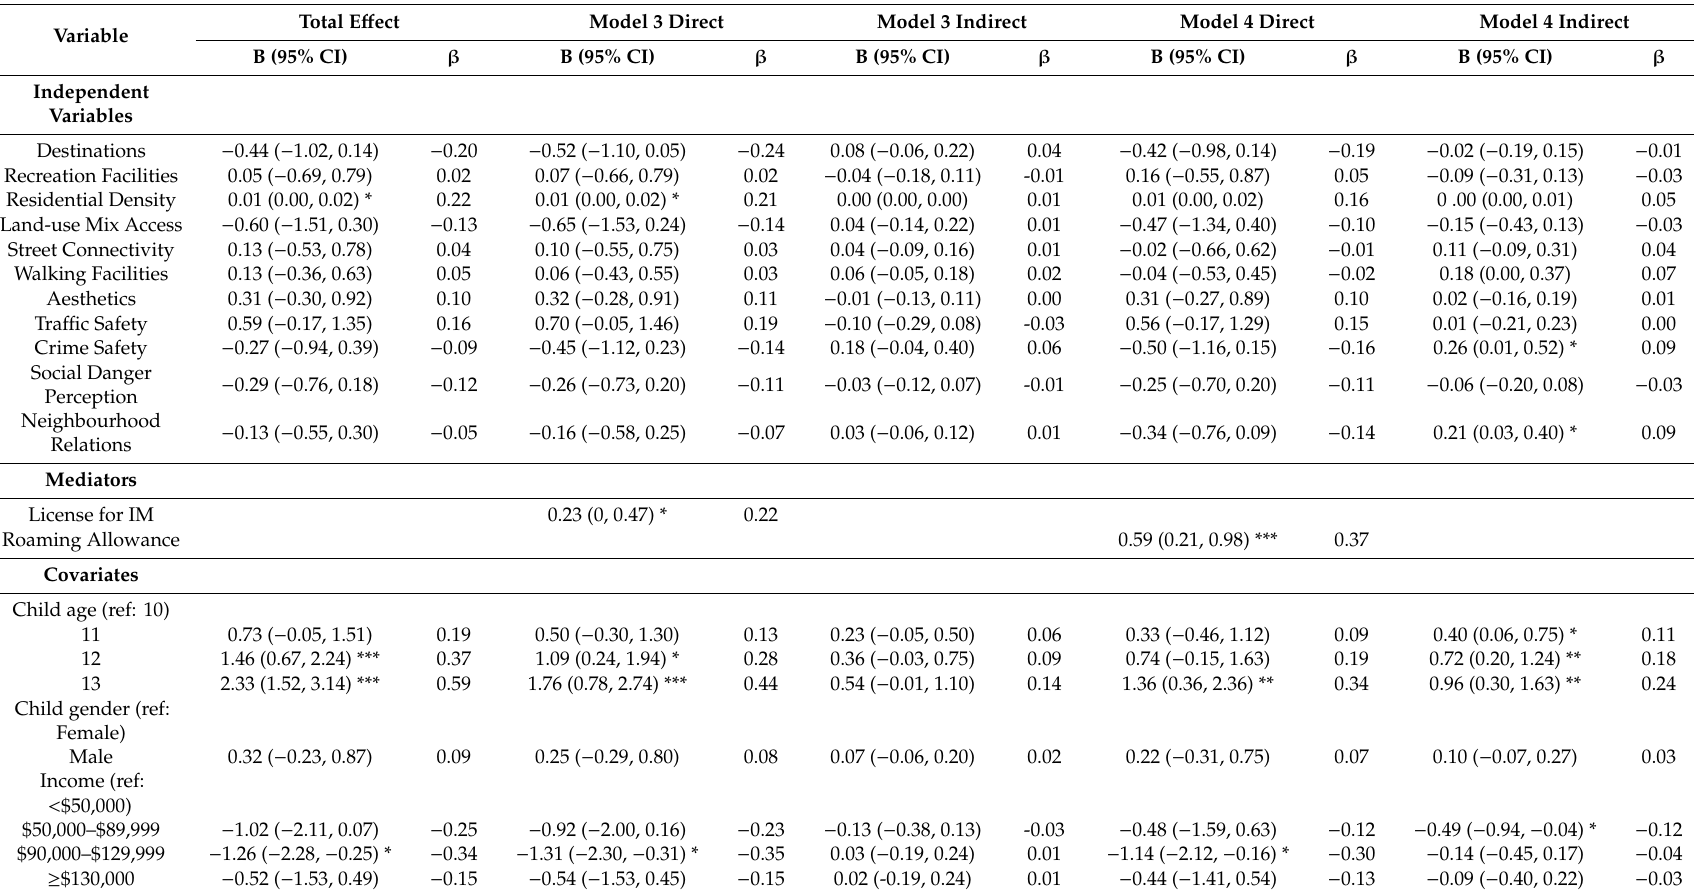
Table 5. Path coe ffi cients for territorial range distance models (N =